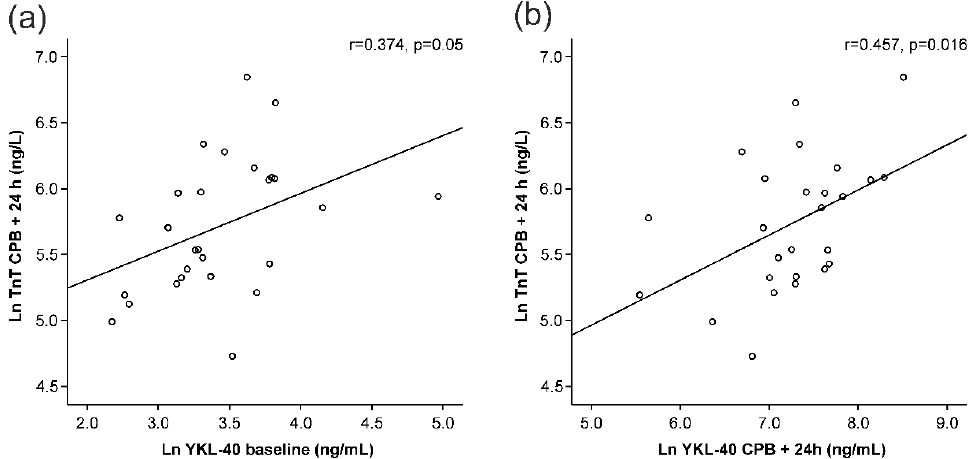
Figure 2. Correlations of troponin T (TnT) levels 24 h after the onset of cardiopulmonary bypass (CPB) to YKL-40 at baseline ( a ) and 24 h after the onset of CPB ( b ). All variables are presented in logarithmic form to obtain normal distributions. Pearson’s correlation was calculated (r). p < 0.05 was considered statistically significant. Table 2. Correlations between baseline (Base) and maximum (Max) YKL-40 levels and baseline levels, maximum levels and areas under curve (AUC) of monocyte chemotactic protein-1 (MCP-1), interleukin-8 (IL-8), 8-isoprostane and troponin T (TnT).